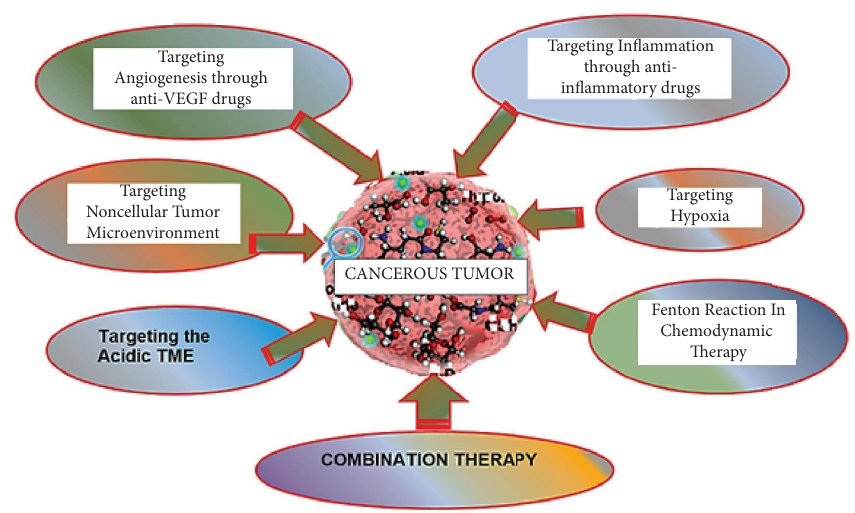
Figure 3: Approaches for targeting the tumor